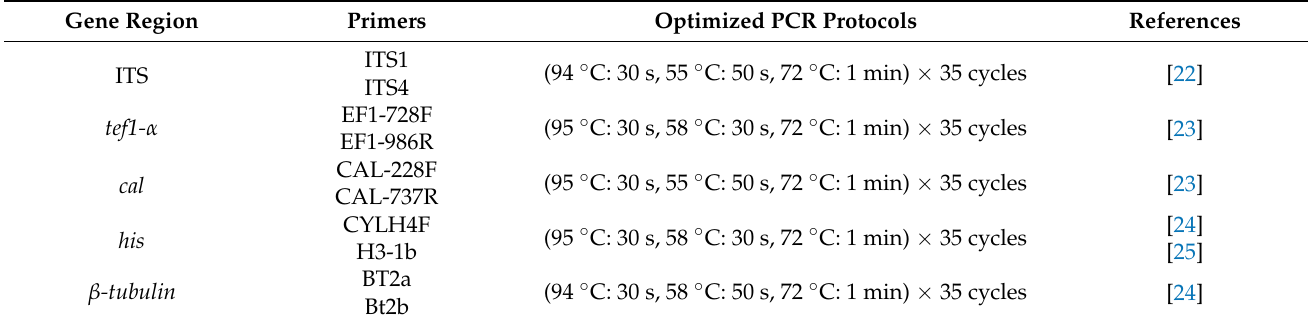
Table 1. Gene regions, respective primer pairs, processes, and references used in the